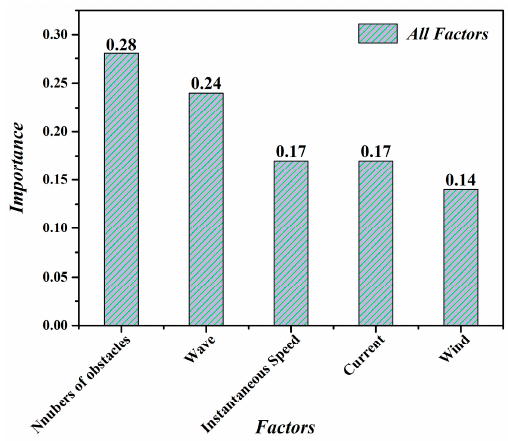
Figure 9. Factor importance after conditional attribute reduction.